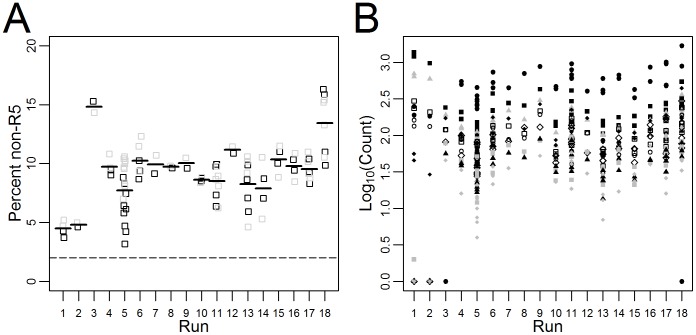
Reproducibility over time by sequence prevalence for a non-homogenous clinical sample (N = 47 replicates over 18 deep sequencing runs).A) The proportion of non-R5 virus (defined as PSSM≥−4.75) measured by sequencing run. Sequences in the “forward” direction are shown in black. Sequences in the “reverse” direction are shown in grey. Thick lines represent the overall mean percentage non-R5 virus measured from all sequences for that run. B) The number of times the 10 most common unique sequences were observed for the non-homogenous clinical sample are plotted against the sequencing run. Each sequence has a unique shade-shape combination.